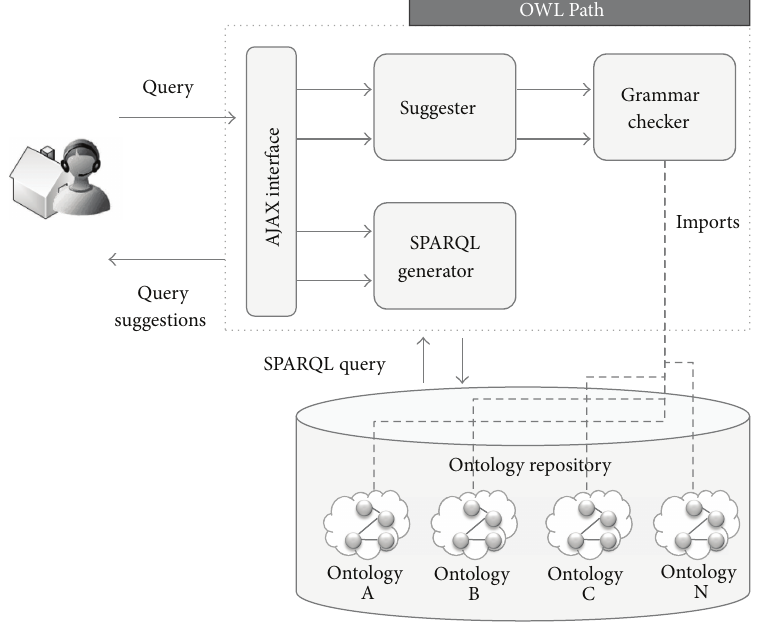
Figure 8: OWL-Path architecture.